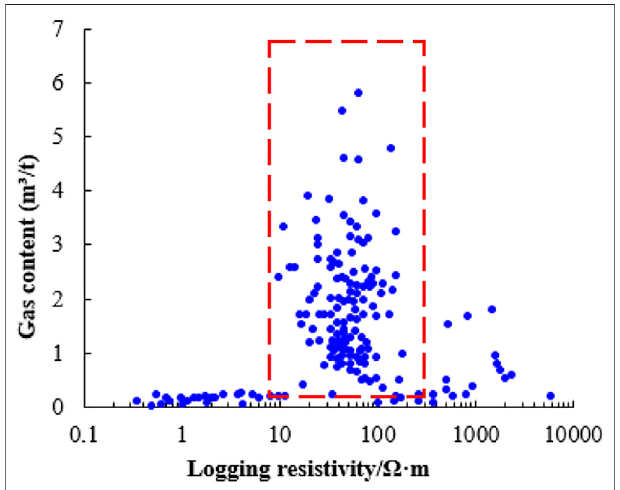
FIGURE 10 | A cross-plot of shale gas content and logging resistivity, Blue dots are data points, within the red circle is medium-resistivity and high- production.